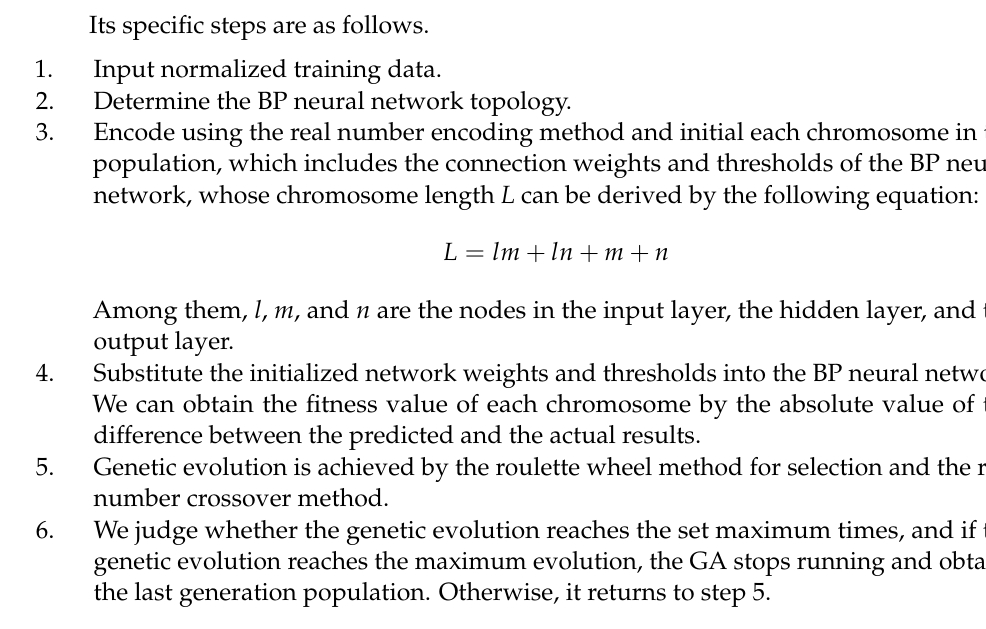
Figure 6. The GA ‐ BP module process. Figure 6. The GA-BP module